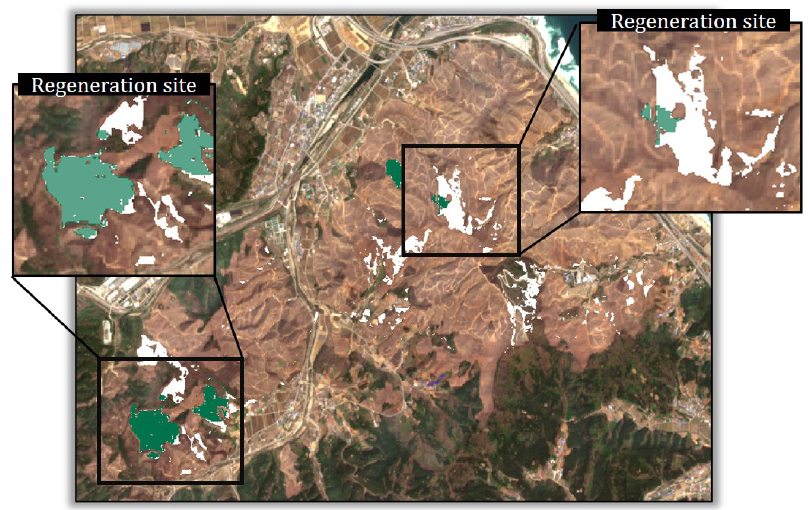
Figure 11. Getis-Ord Gi* statistics analysis: the green areas indicate the Getis-Ord Gi* statistics results, and the brighter areas indicate the vegetation regeneration area extracted using three